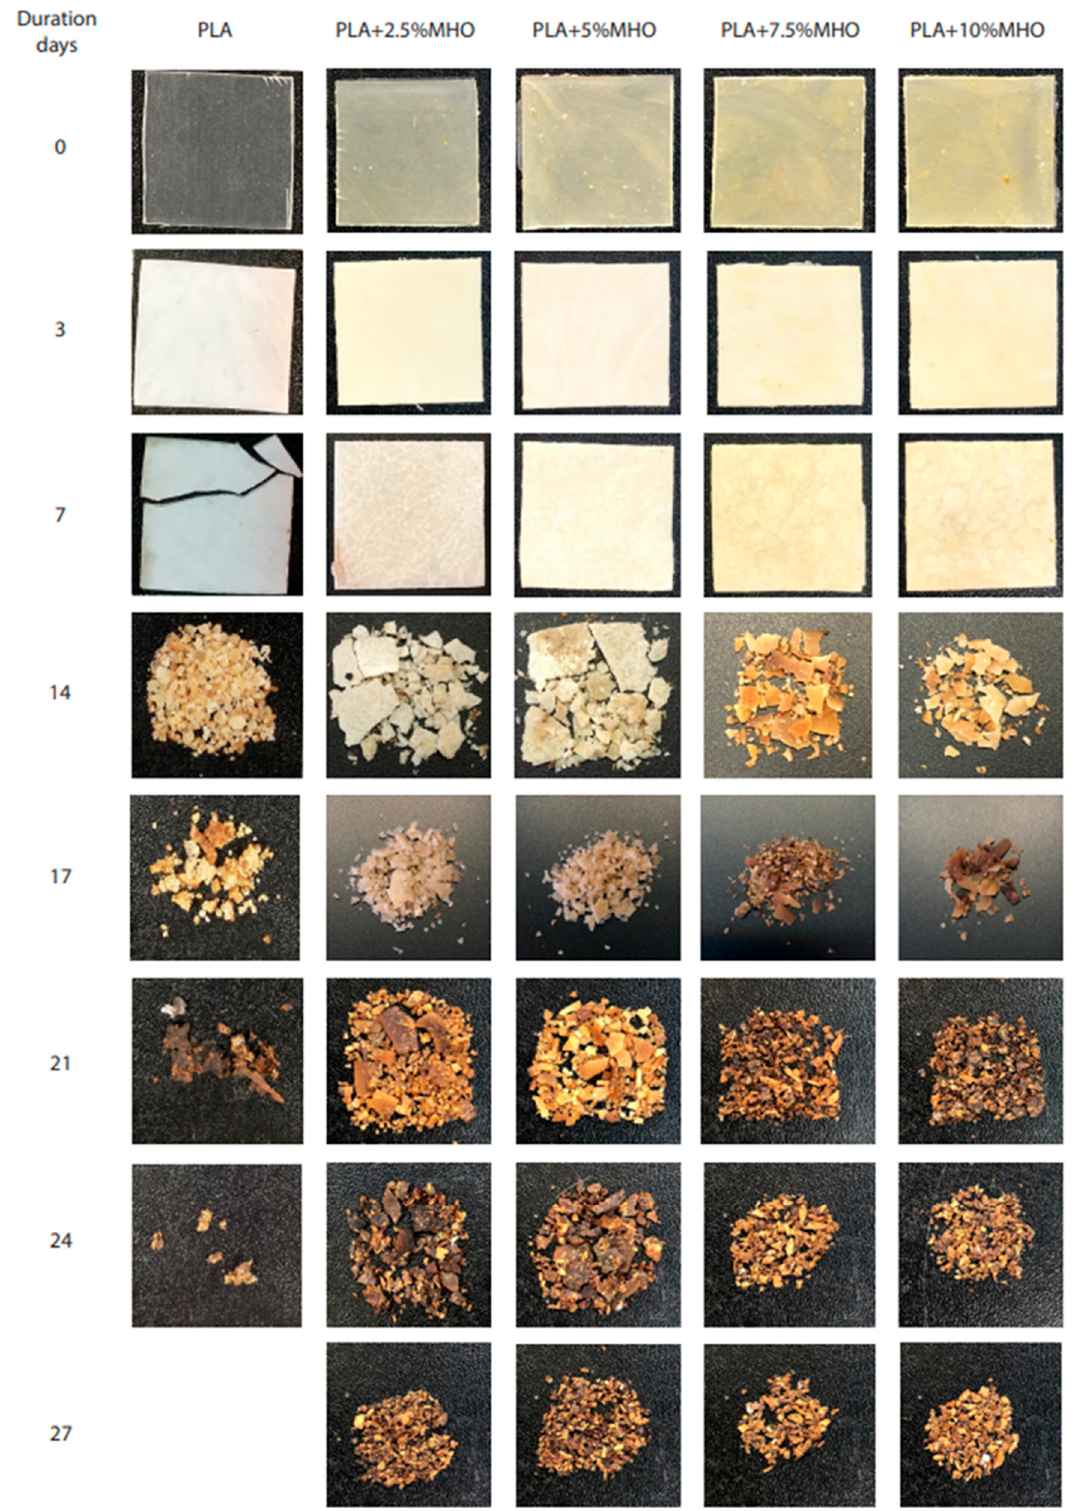
Figure 12. Visual appearance of disintegration under composting conditions of PLA and PLA plasticized with different contents of MHO.